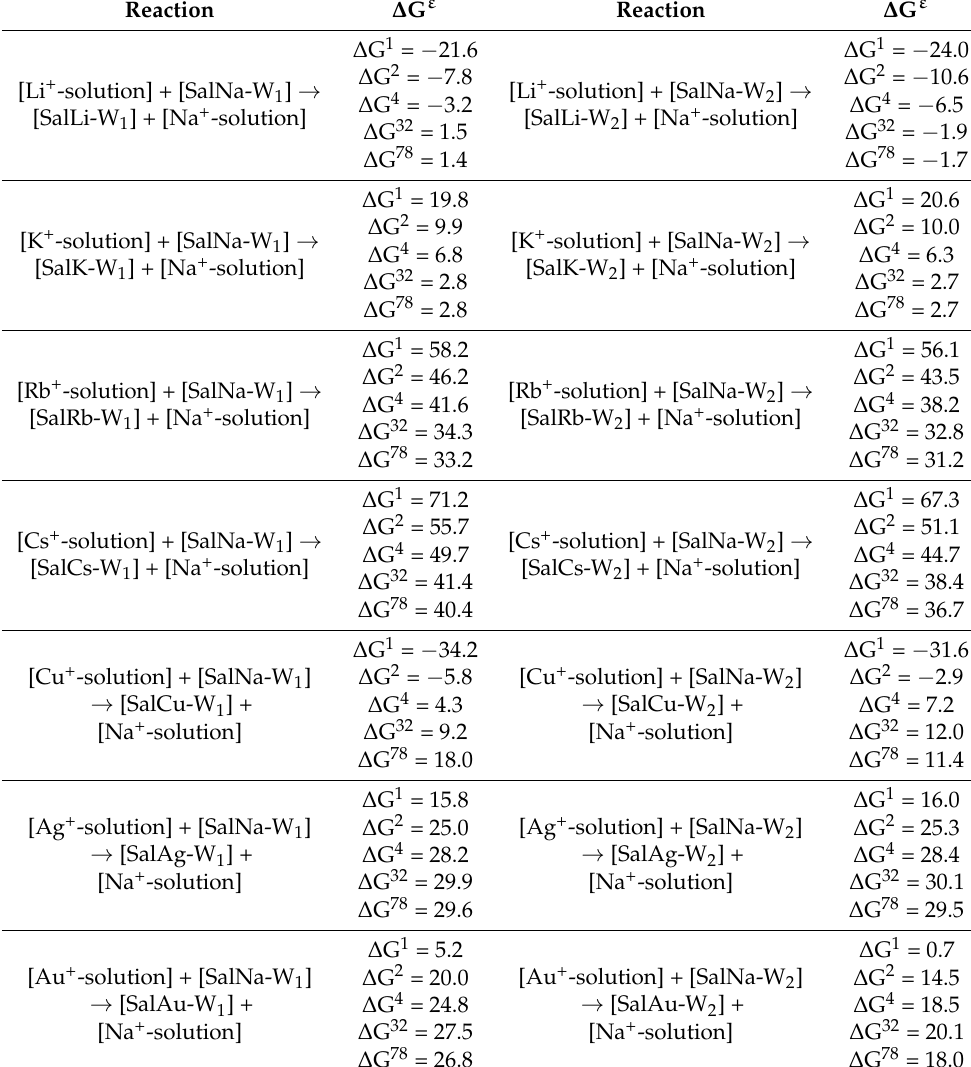
Table 2. Gibbs free energies of M + /Na + metal substitution ( ∆ G ε , kcal/mol) for Equation (1), evalu- ated in media with different dielectric constant ε . Reaction ∆ G ε Reaction ∆ G